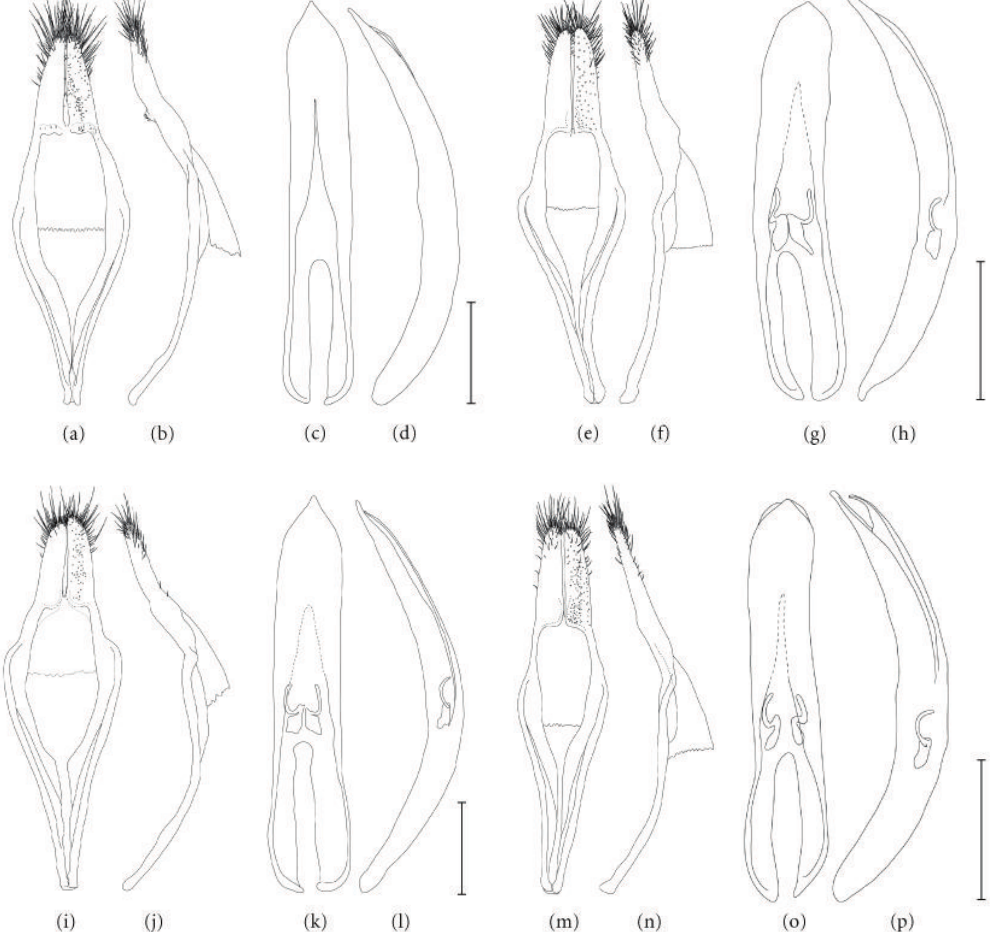
Figure 7: The male genital organ of Agelasta ( Dissosira ) spp. (a–d) A. ( D. ) catenata ; (e–h) A. ( D. ) perplexa ; (i–l) A. ( D. ) rufa ; (m–p) A. ( D. ) konoi ; (a, e, i, m) tegmen in ventral view; (b, f, j, n) ditto in lateral view; (c, g, k, o) median lobe in ventral view; (d, h, l, p). ditto in lateral view. Scale: 1.0